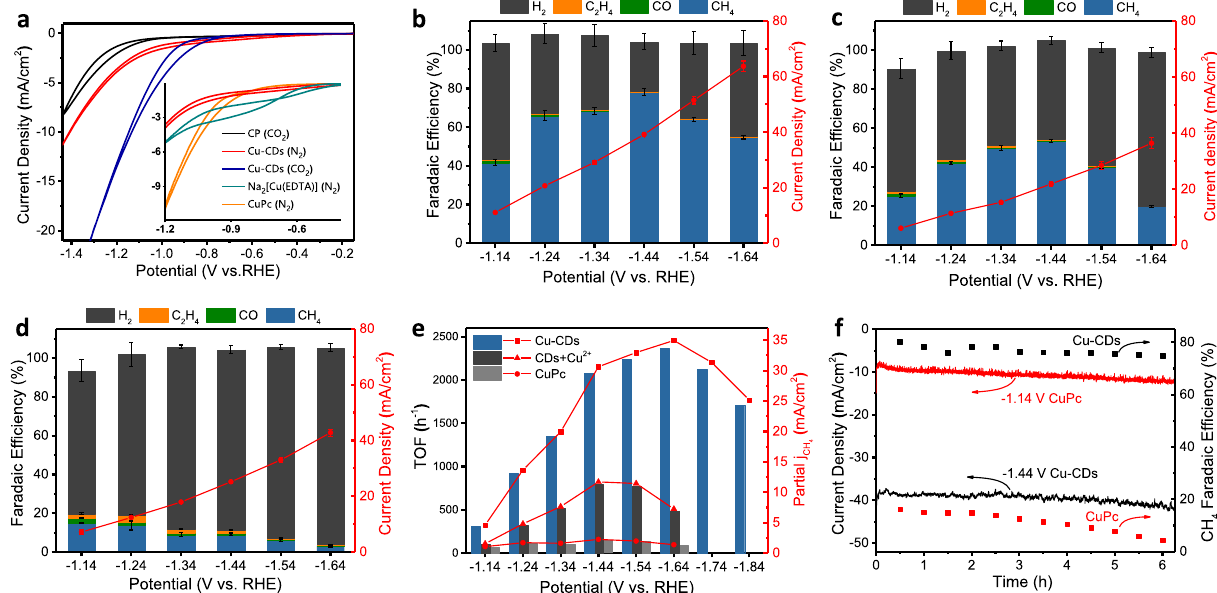
Fig. 3 CO 2 reduction in aqueous solution. a CV curves of bare carbon paper (CP), Cu-CDs, Na 2 [Cu(EDTA)], and CuPc recorded in N 2 - and CO 2 -saturated 0.5 M KHCO 3 electrolyte with 10 mV/s scan speed. b, c, d Dependence of FE (left y -axis) and current density (based on geometric surface area, right y -axis) of ( b ) Cu-CDs, ( c ) CDs + Cu 2 + , and ( d ) CuPc on the applied potential. e Partial CH + Cu 2 + , and 4 current density plots and TOFs of Cu-CDs, CDs CuPc at different applied potentials. f Stability test of Cu-CDs and CuPc at their highest ECR Faradaic ef fi ciency